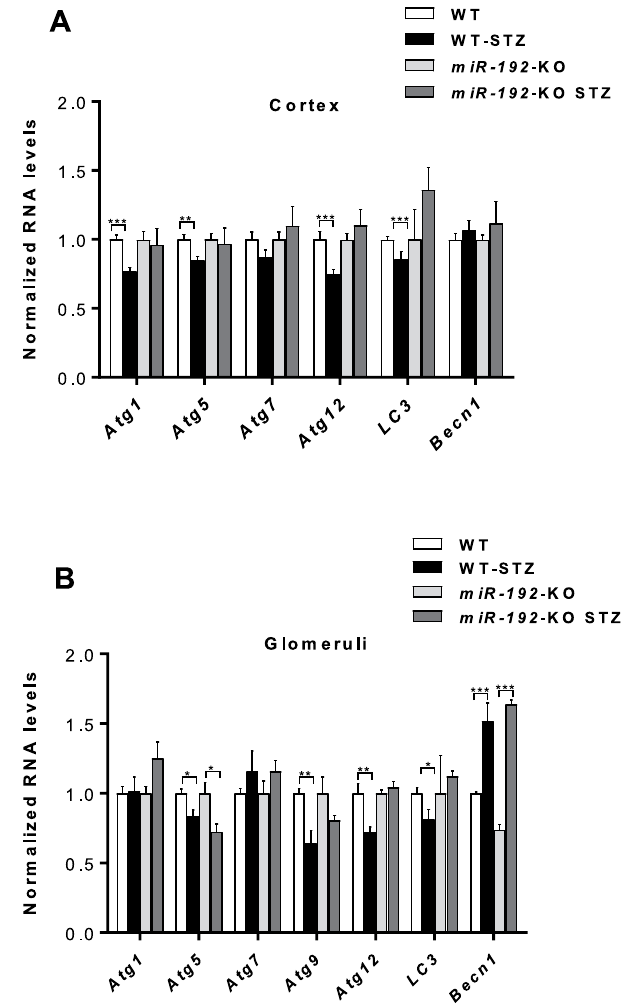
Figure 3. Decreased expression of key autophagy genes in kidneys of WT-STZ mice compared to WT controls is not observed for majority of genes in miR-192-KO-STZ mice compared to miR-192-KO control mice.qRT- PCR analysis of autophagy genes in ( A ) kidney cortex lysates and ( B ) kidney glomerular lysates; from WT control (n = 6) and WT-STZ (n = 5) mice and miR-192-KO control (n = 3) and miR-192-KO-STZ (n = 6) mice 22 weeks after induction of diabetes. * P < 0.05; ** P < 0.01; *** P <